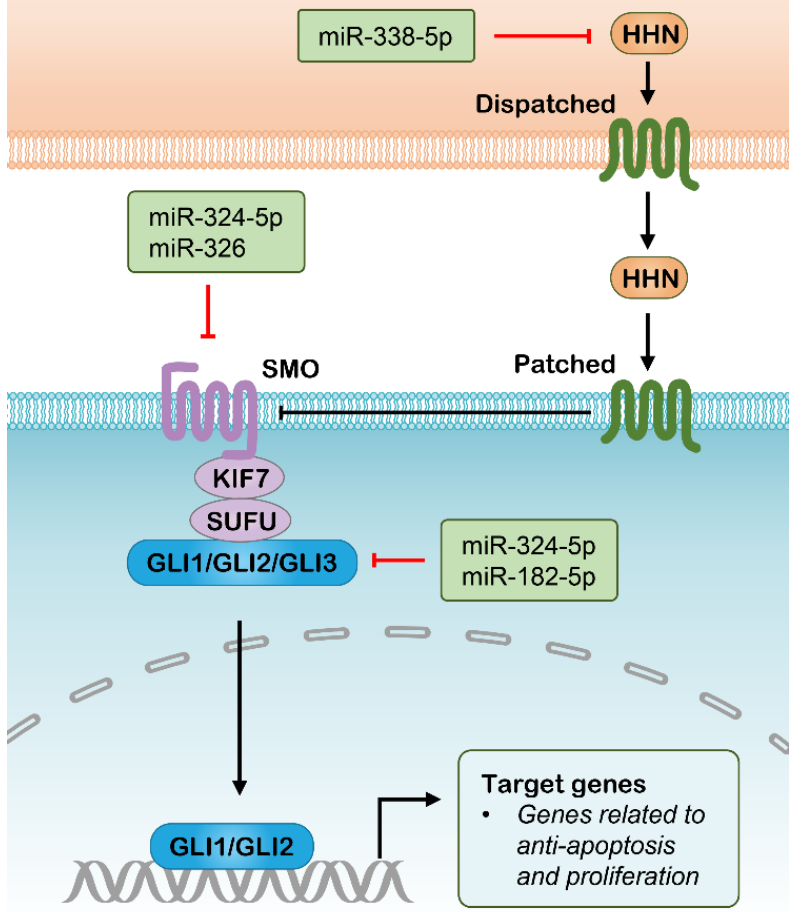
Figure 4. Hedgehog signaling pathway and potential RNAi targets. HHN, Hedgehog N–terminal fragment; SMO, Smoothened; KIF7, Kinesin family member 7; SUFU, suppressor of fused homologue; GLI, Glioma-Associated Oncogene Homolog 1.